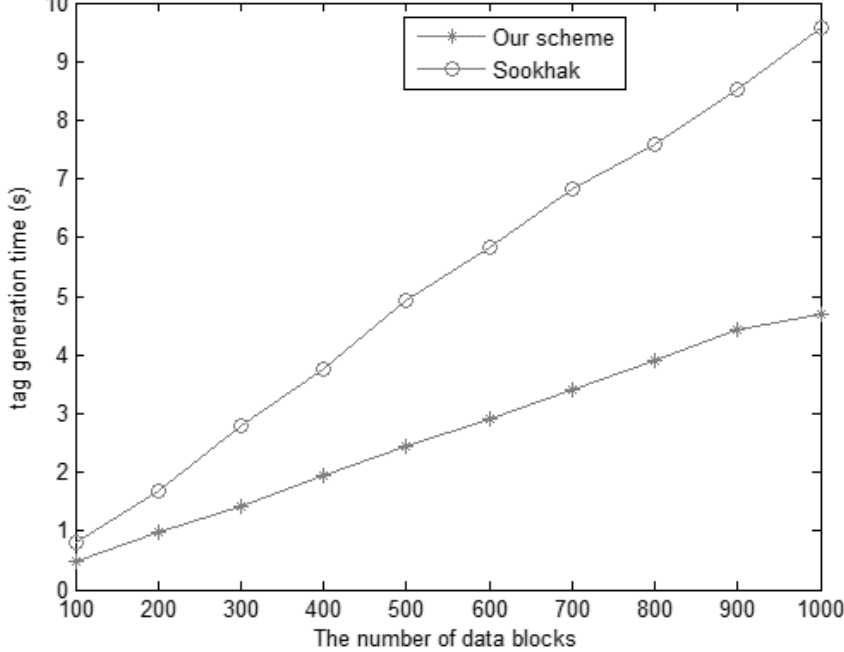
Figure 7. The computational time of generating data block